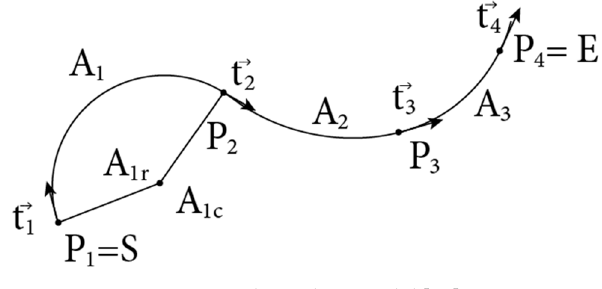
Figure 5. The arcline model [22].